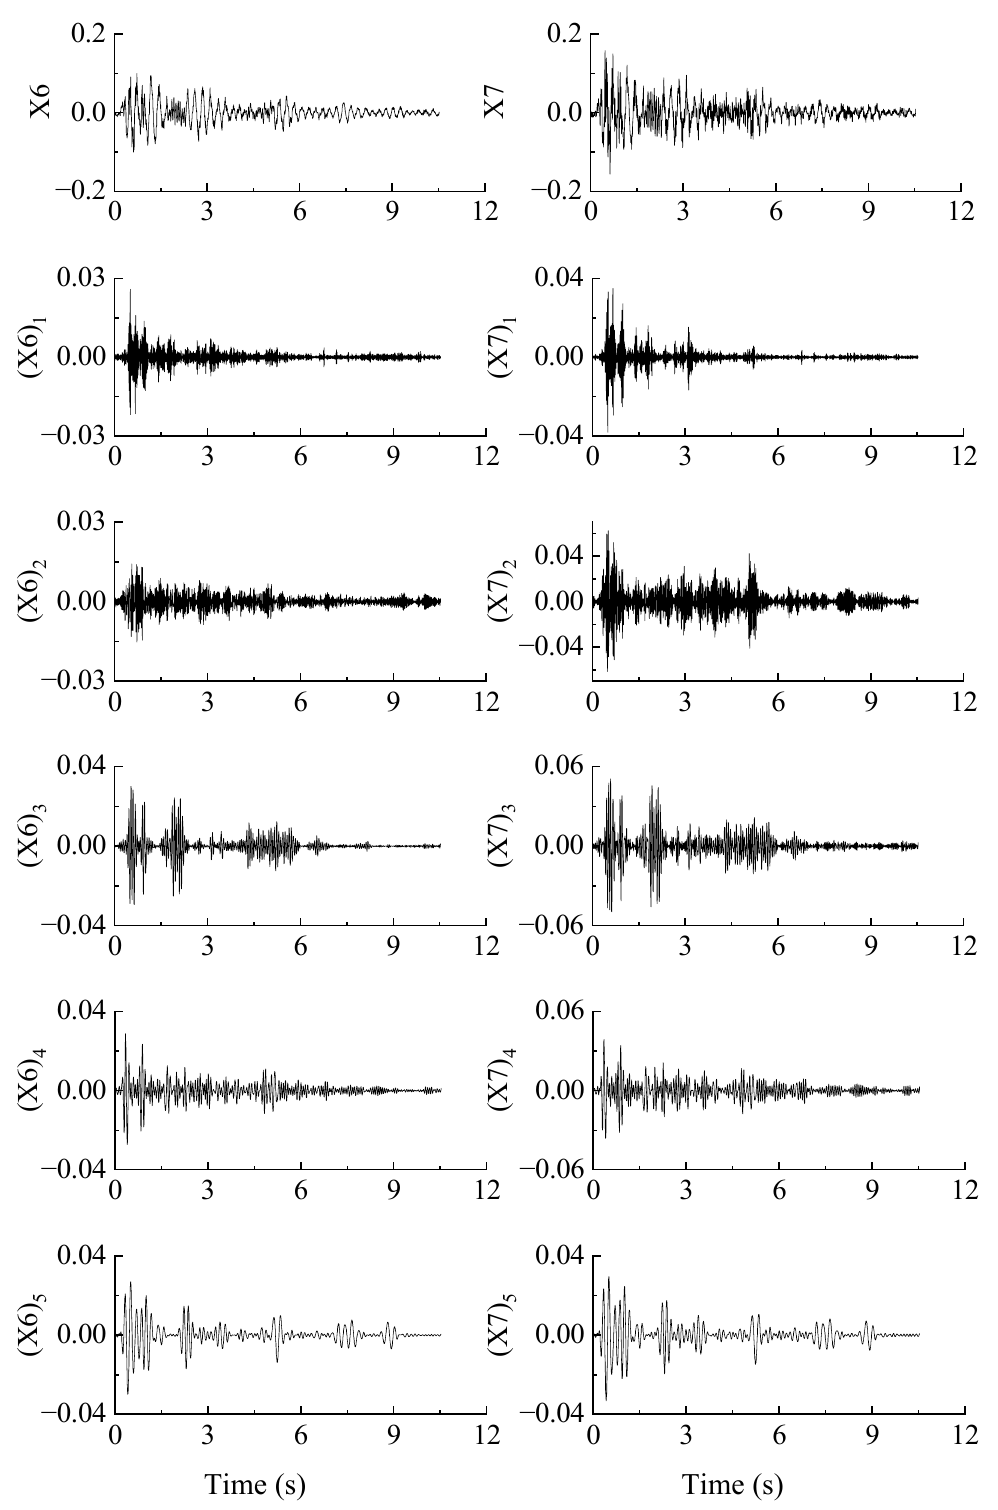
Figure 8. First five IMFs of the shaking table test by MEMD decomposition. The identified frequencies and damping ratios of the first four modes are summa- rized in Tables 4 and 5, together listing the frequencies of FEM and other results identified by ERA methods [12]. It can be observed that the frequencies identified from the seismic